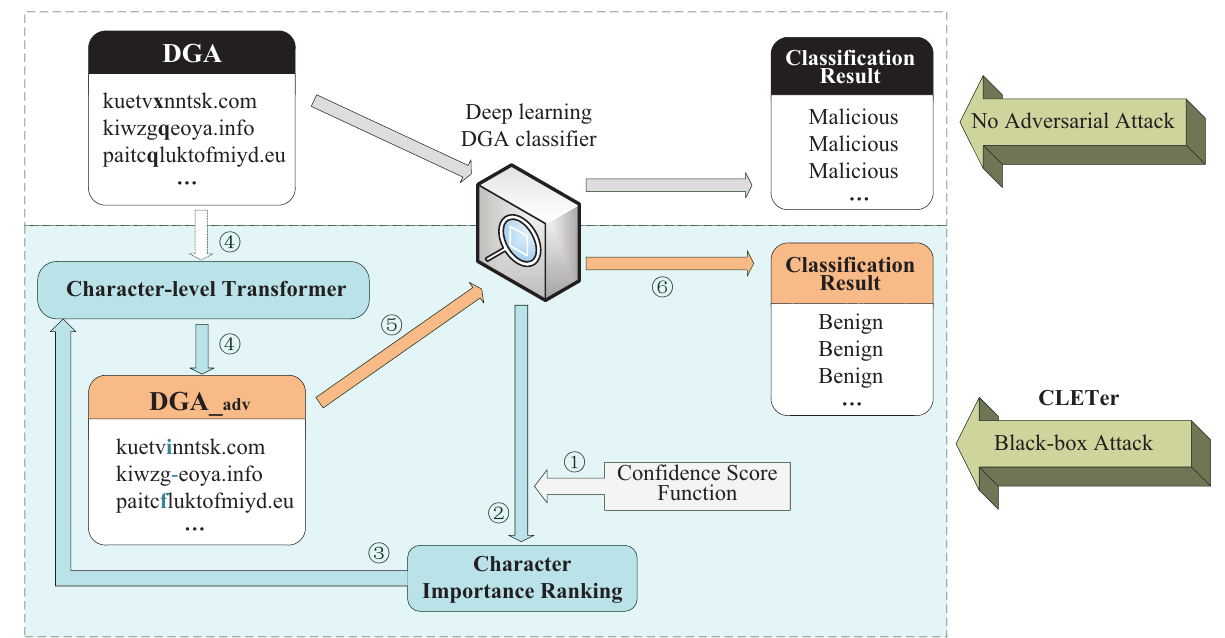
Figure 1. Implementation of CLETer. In the top part, DGA domain names are classified as malicious when no adversarial attack happens. In the bottom part, the adversarial examples generated by the black-box attack of CLETer are classified as benign. Firstly, for the existing DGA domain names, get the character importance ranking based on the confidence score function ( 1O- 2O). Secondly, perform character-level transform to get adversarial domain names ( 3O- 4O). Finally, the adversarial examples are misclassified as benign by targeted classifiers ( 5O-